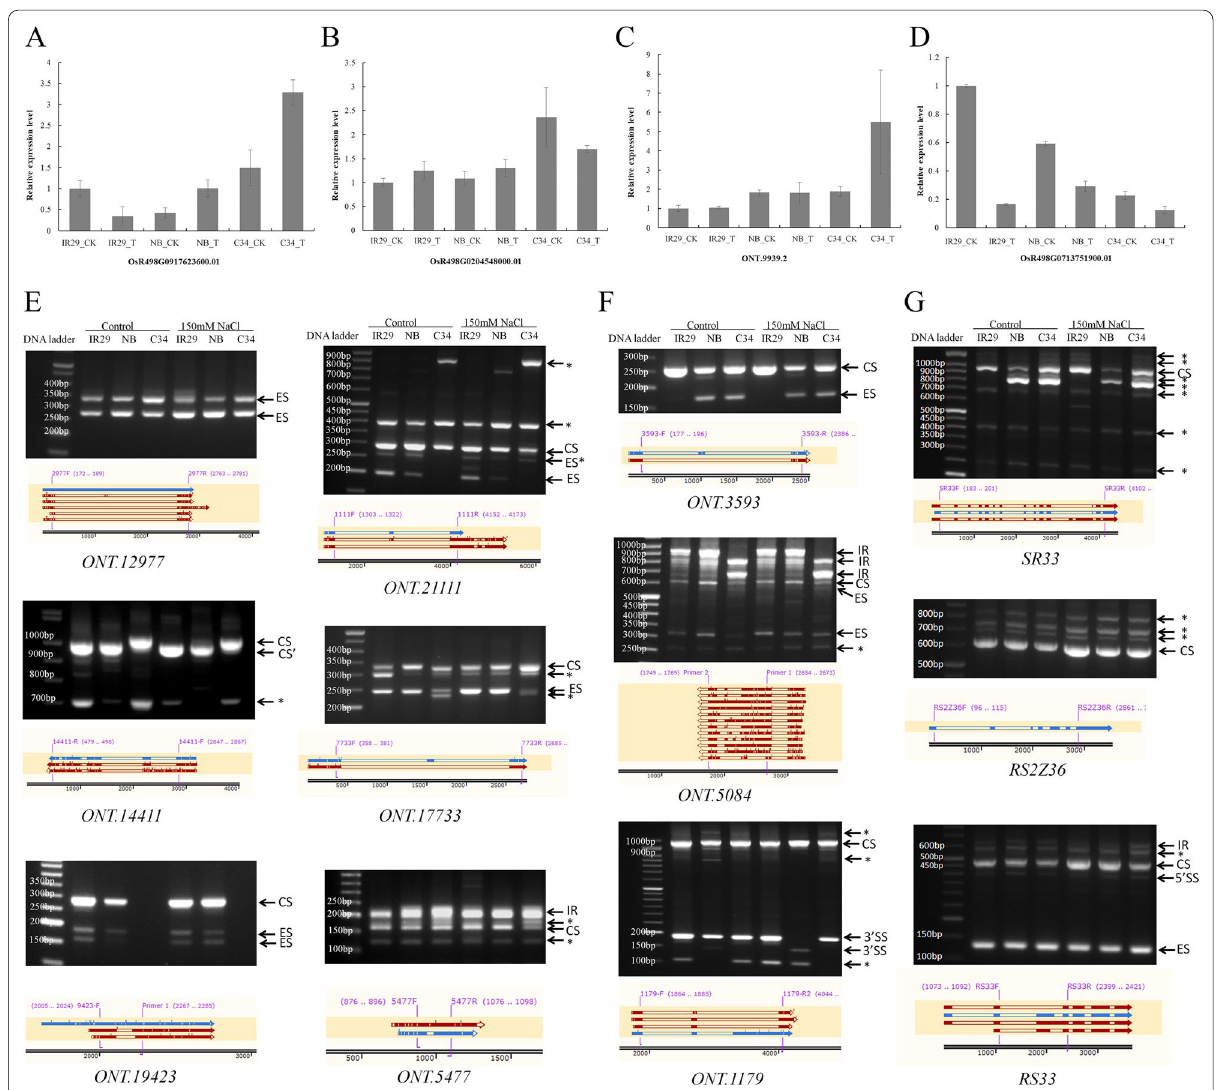
Fig. 8 PCR validation of RNA-Seq data. Several differential expressed genes detected in RNA-Seq data were used to do qRT-PCR validation. A and B . Two salt-induced genes were expressed at higher levels in ‘C34’. C . A lncRNA induced significant induced in ‘C34’ by salt stress. D . A salt-suppressed gene show less expression in ‘C34’ when compared with ‘NB’ and ‘IR29’. E – G . RT-PCR test pre-mRNA alternative splicing events. Schematic diagram generated from comparison of genome sequence, supposed reference mRNA sequence and sequencing results in SnapGene program is shown below each RT-PCR gel electrophoresis. The AS type of PCR amplified fragment was marked by arrows with legend. CS: Constitutive splicing; ES: Exon skipping; IR: Intron retention; 3’SS: Alternative 3’ splice site; 5’SS: Alternative 5’ splice site; “*” means AS type needs further determined. E . RT-PCR validation of alternative splicing of coding genes. F . RT-PCR validation of alternative splicing of lncRNAs. G . RT-PCR test pre-mRNA splicing patterns of SR